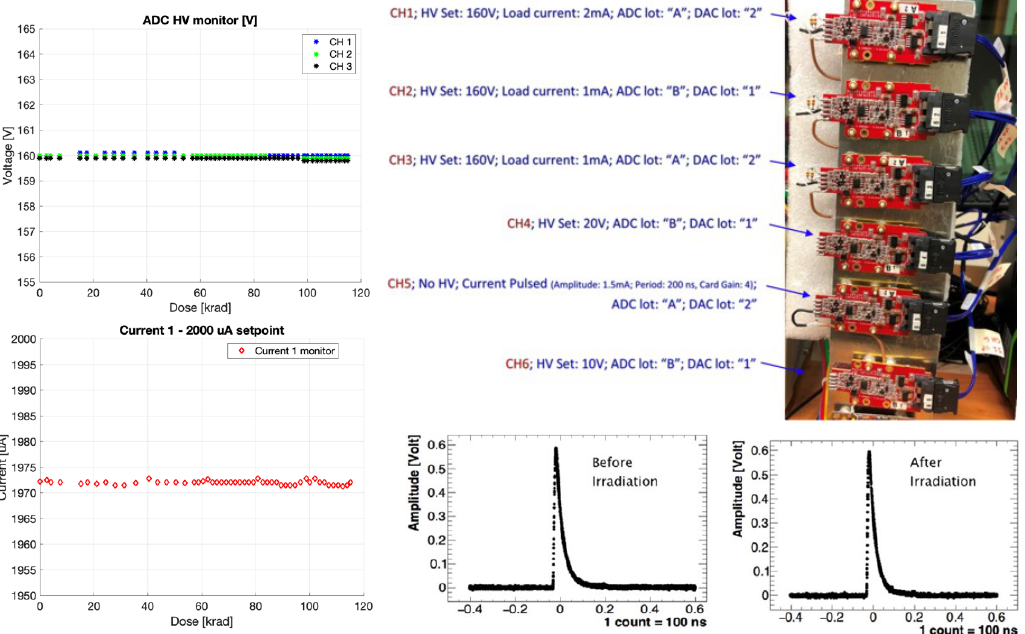
Figure 8. Top-right : configuration for the final FEE TID test. Left : example of stability plots for regulator voltage and current during irradiation. Bottom-right : waveforms comparison before and after TID